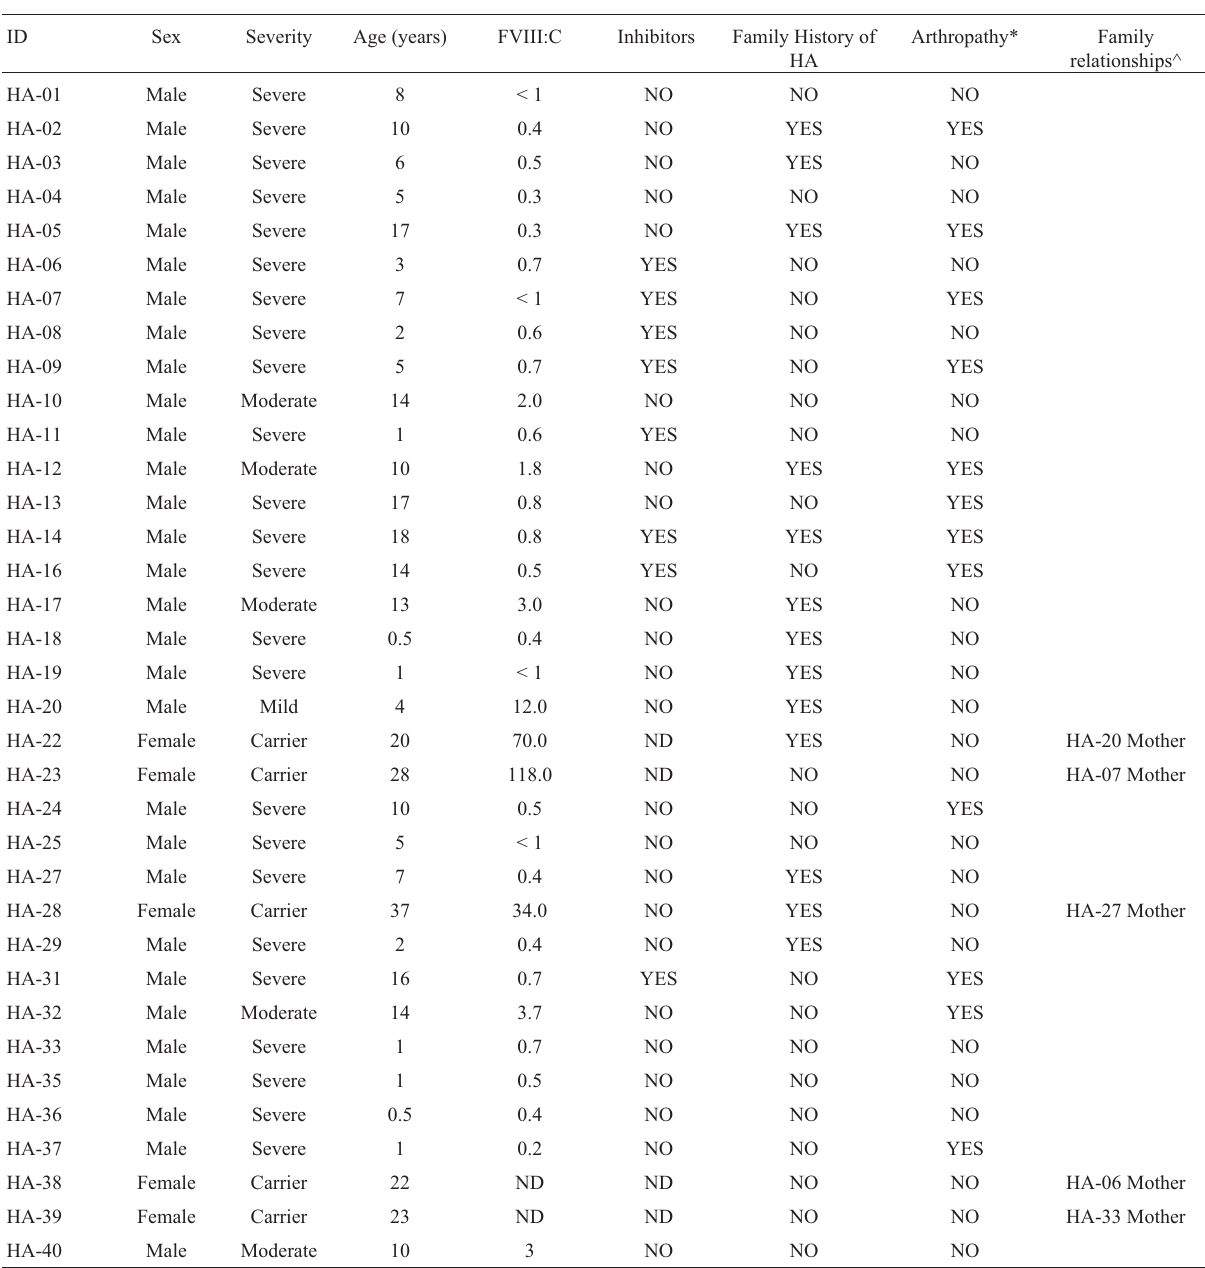
Table 1 - Clinical and demographic data of hemophilia A patients from